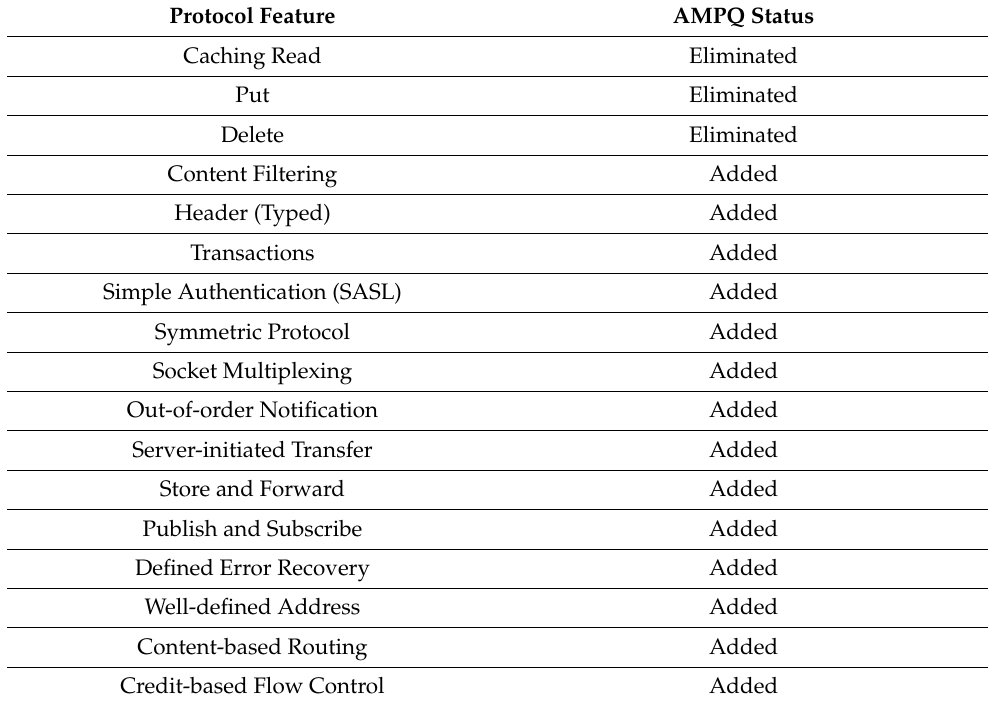
Table 7. Features that optimize AMQP for scalability, security, and homogeneous networking solutions. Protocol